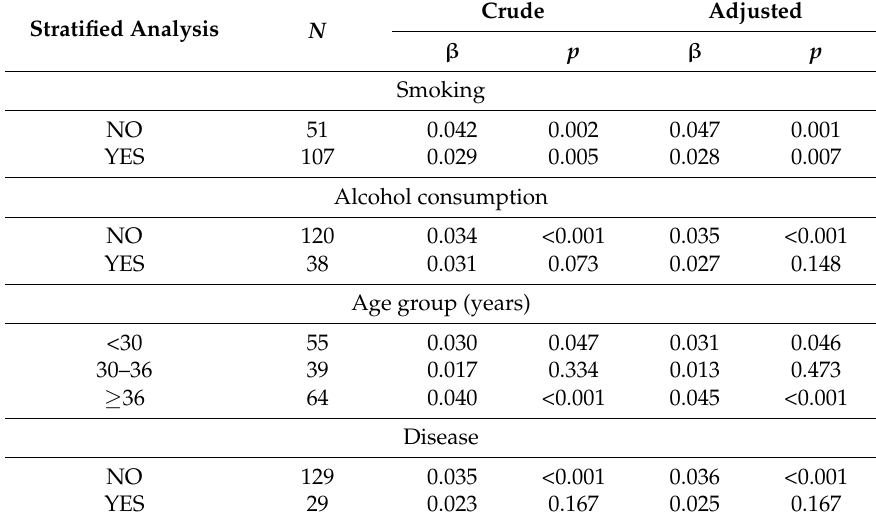
Stratified Analysis N